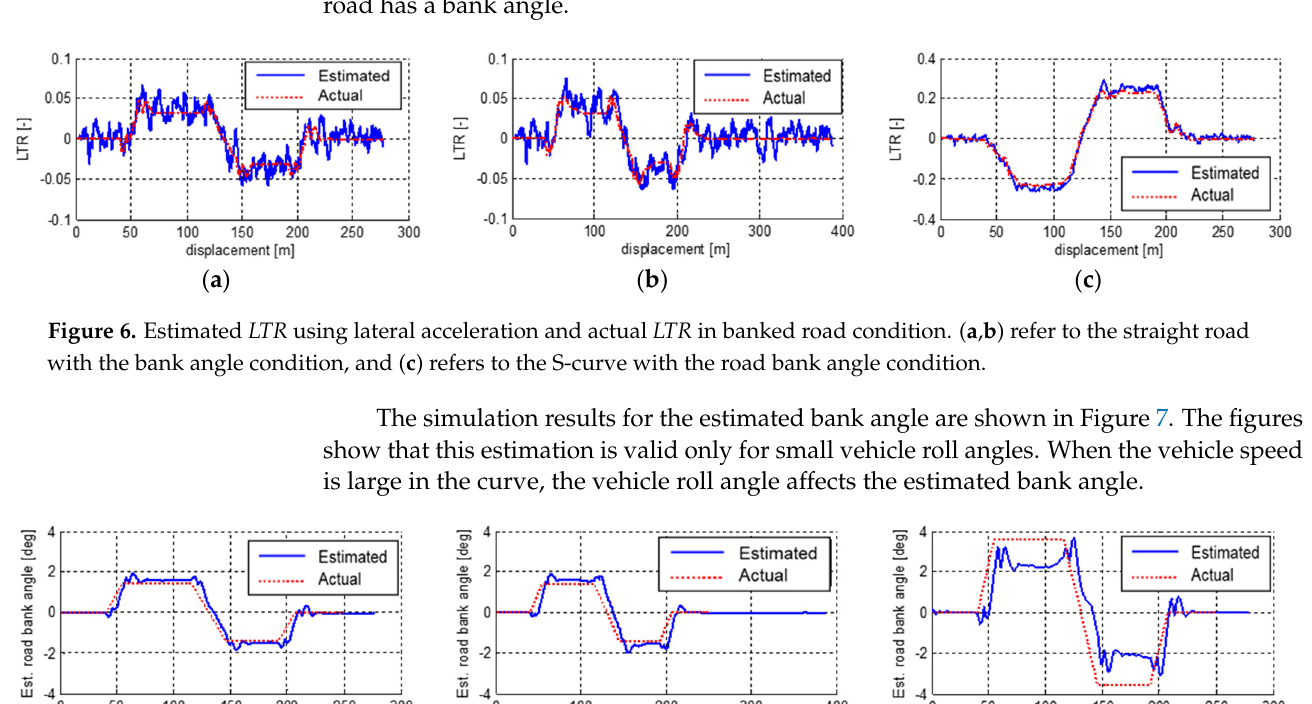
Figure 7. Estimated bank angle. ( a , b ) refer to the straight road with the bank angle condition, and ( c ) refers to the S-curve with the road bank angle condition.